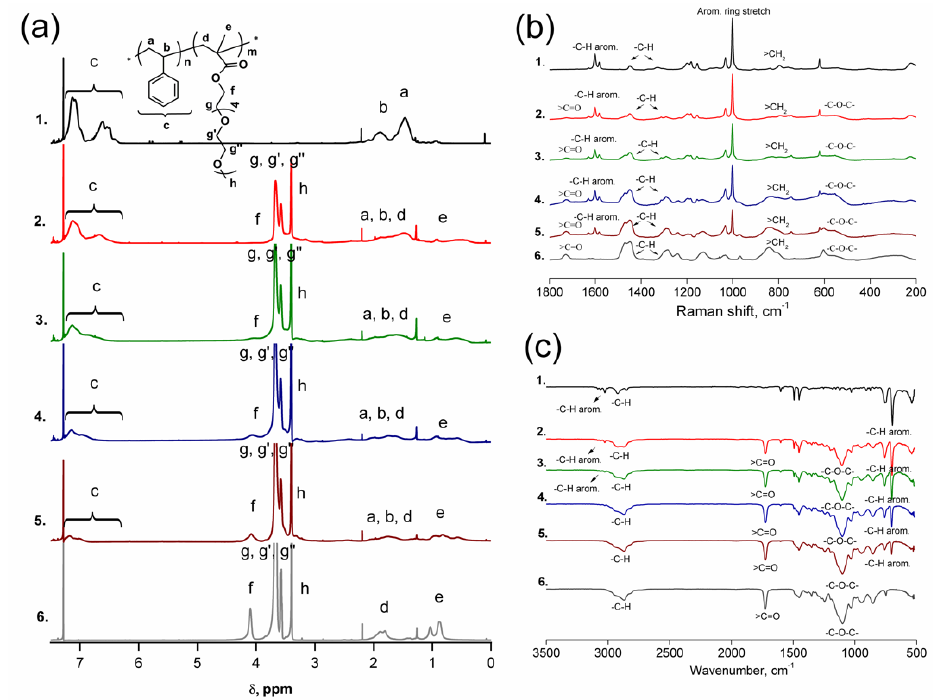
Figure 3. 1 H NMR ( a ), RAMAN ( b ), and FTIR ( c ) spectra of p (St) (1), p (PEO 5 MEMA) (6) and p (St- co - PEO 5 MEMA) copolymers with different composition. ([St] 0 :[PEO 5 MEMA] 0 : 8:2 (2) 6:4 (3), 4:6 (4), 2:6 (5).